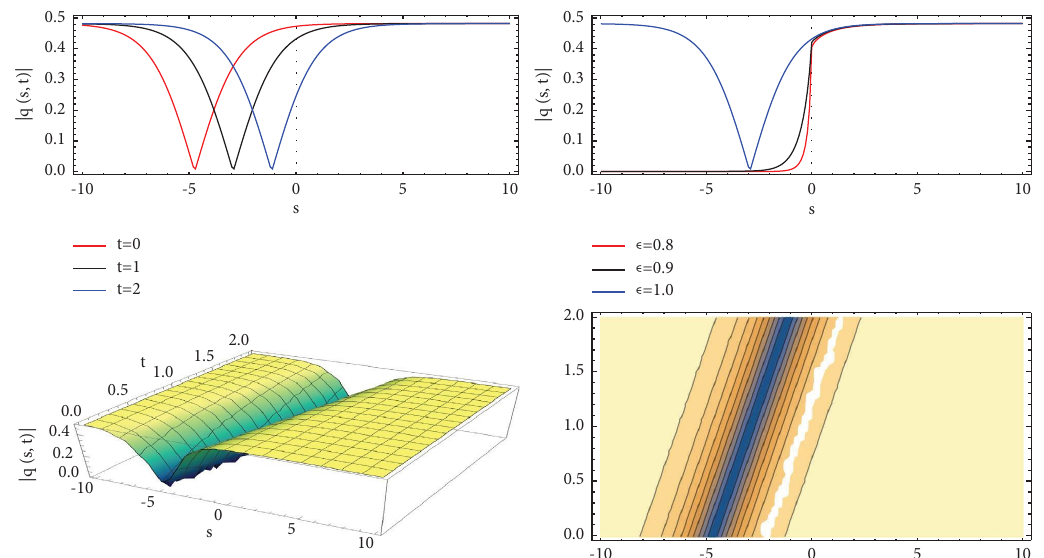
Figure 3: Structure of (66) for δ � 0 . 3 , λ � 0 . 4 , ϱ � 0 . 5 , μ � 6 , Ω � 0 . 4 , d � 0 . 17 ,a � 0 . 1 ,c � 0 . 01 ,b � 0 . 4 ,C